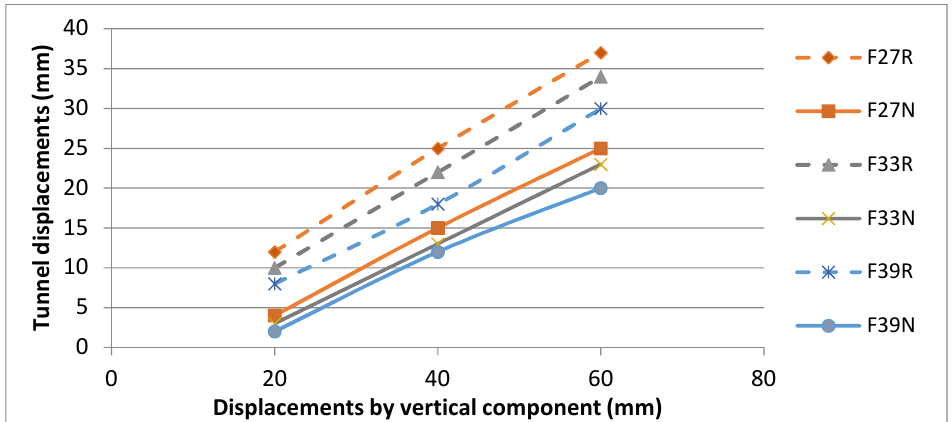
Figure 8. The effect of friction angle on reverse and normal faults.